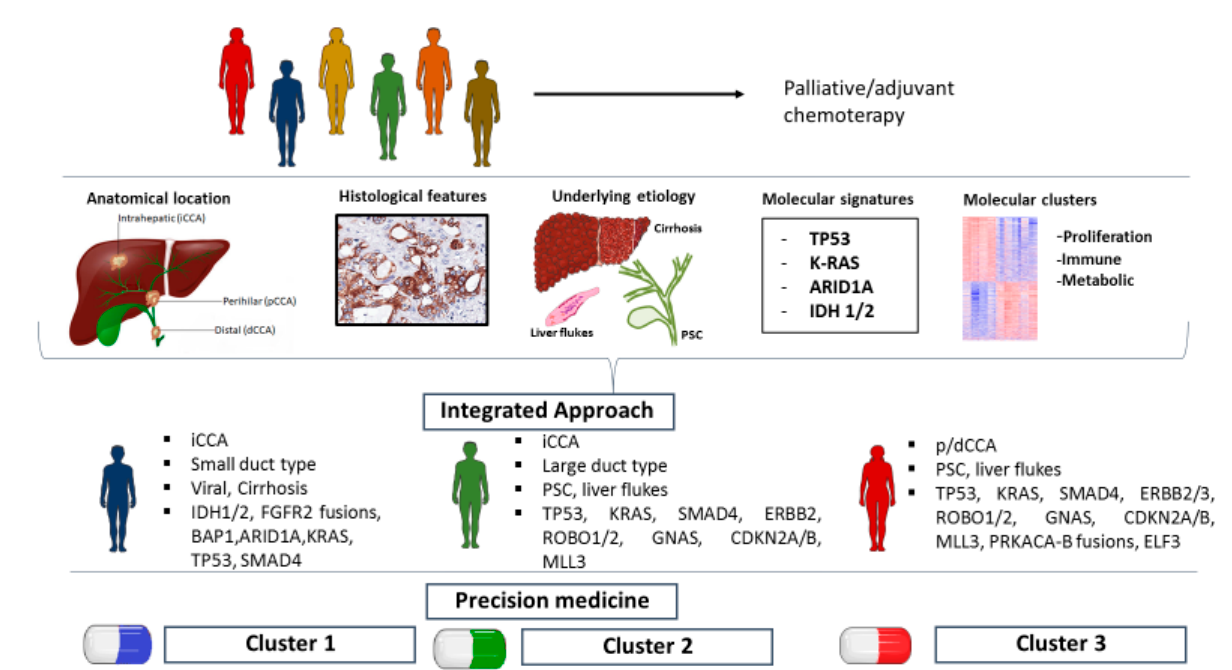
Figure 1. Integrated approach for CCA patient stratifications and clinical perspectives, based on the anatomical location, histological and clinical features and molecular signatures and clusters.